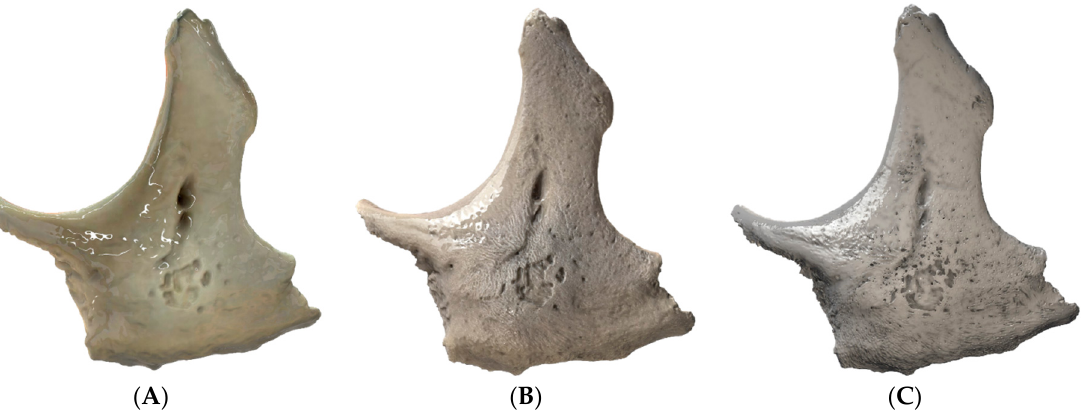
Figure 3. 3D models with an applied shader, light sources, global illumination, ambient occlusion, and post-process filters, on Sketchfab platform created by using different techniques. ( A ) 3D scanning, ( B ) photogrammetry, ( C ) micro-computed